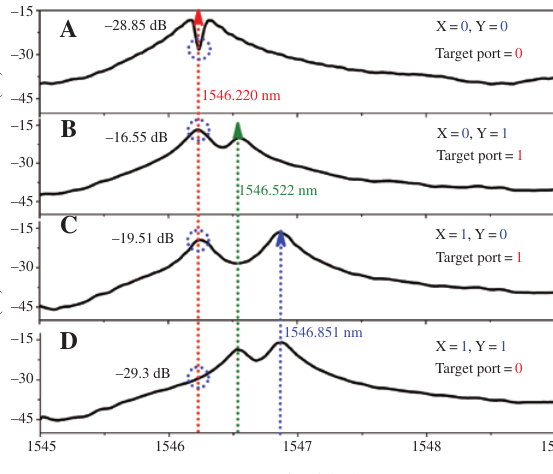
Figure 4: Response spectra of the device at the Target port with the applied voltages to the micro-heaters over MRR and 0.55 V, (B) 0 V and 1.71 V, (C) 1.93 V and 0.55 V, (D) 1.93 V and